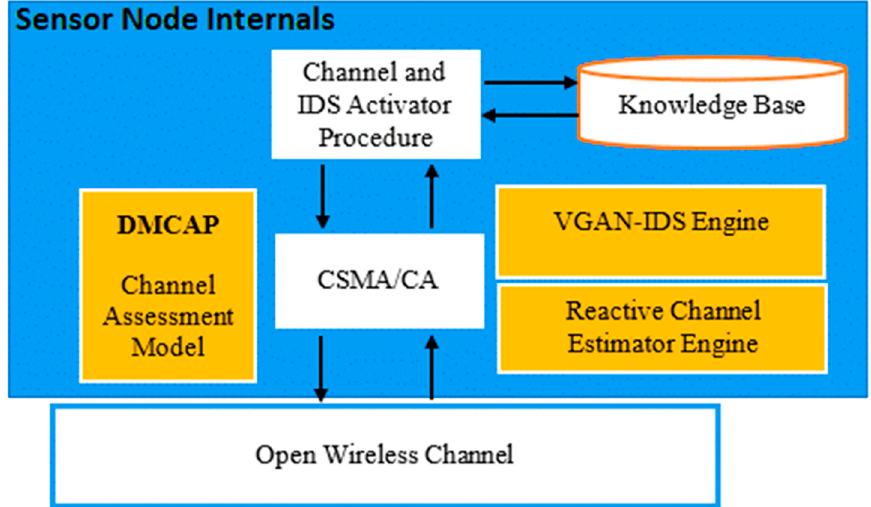
Figure 3. Proposed DMCAP system in sensor node .